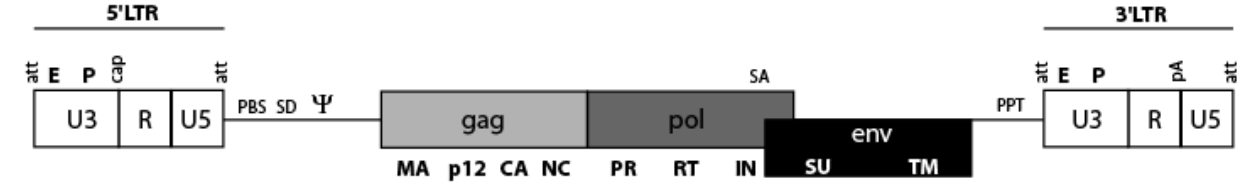
Figure 1. Proviral genome structure of the Murine Leukemia Virus (MLV), a simple retrovirus. Indicated are the 5’ and 3’ long terminal repeat (LTR; open boxes) regions comprising U3, R and U5, as well as open reading frames (filled boxes) for gag, pol and envelope (env) proteins. Processed protein subunits are indicated in bold. att, attachment site; cap, 5’RNA capping site; pA, polyadenylation site; PBS, primer binding site; SD, splice donor;  , packaging signal; SA, splice acceptor; PPT, polypurine tract; MA, matrix; CA, capsid; NC, nucleocapsid; PR, protease; RT, reverse transcriptase; IN, integrase; SU, surface; TM, trans-membrane; E, enhancer; P,